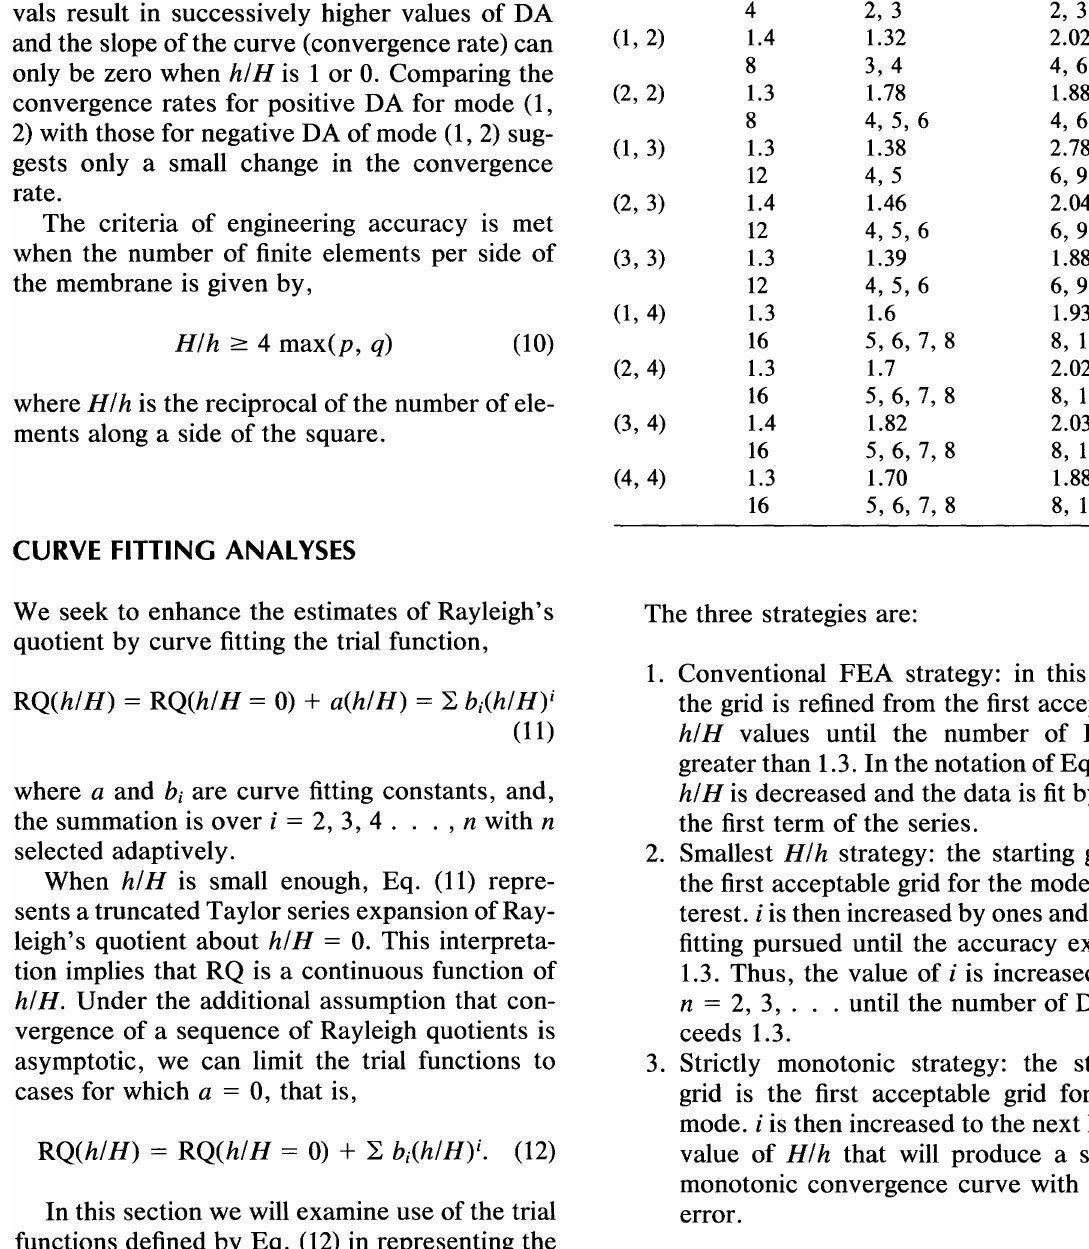
Table 2. Enhanced Estimates of Rayleigh's Quotient Cell Contents, Digits, RQ; Grid Hlh Conventional Smallest Hlh Strictly